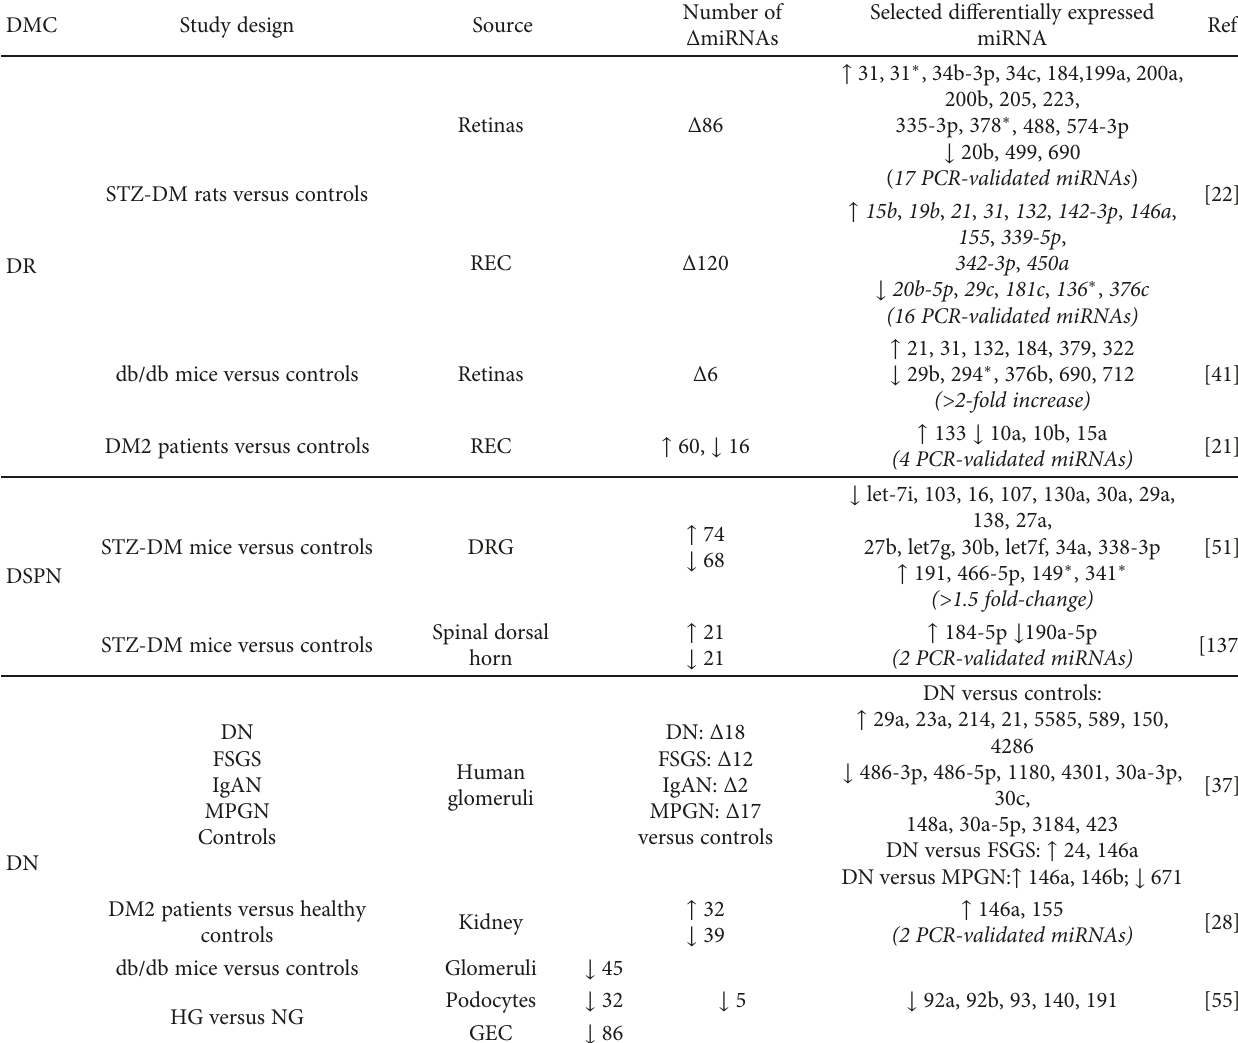
Table 1: miRNA pro fi ling studies in diabetic microvascular